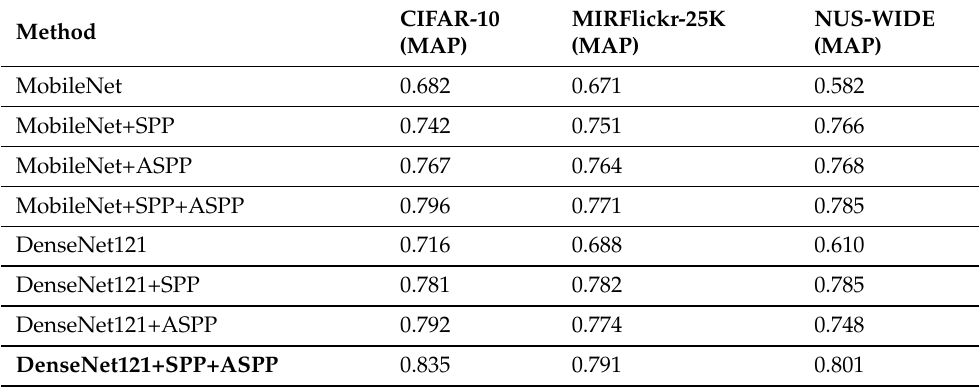
Table 2. A comparison of different architectural constructions of the AutoRet .